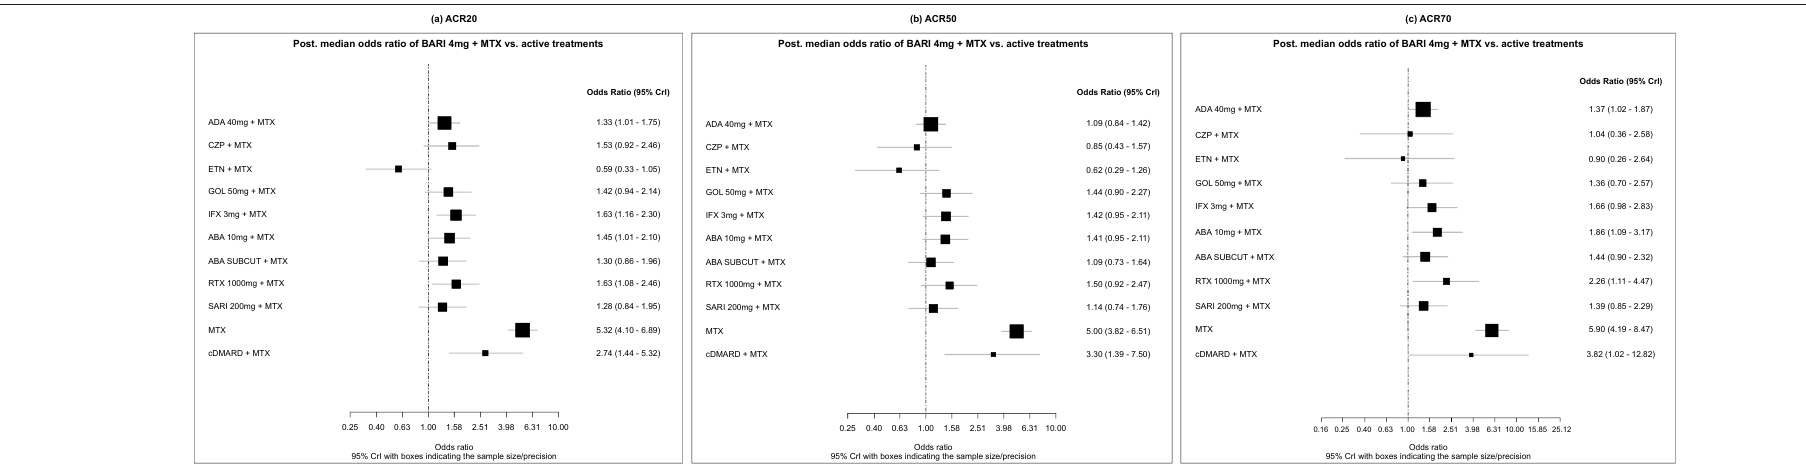
Figure 2. Forest Plots (ACR20/50/70) - (MTX-IR Population; Primary Analysis)